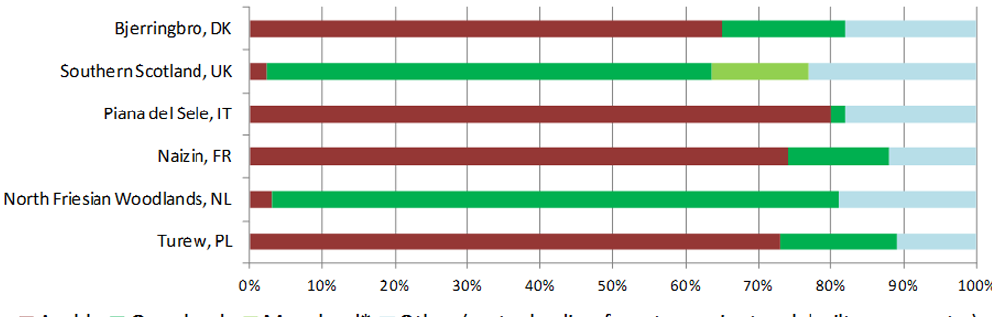
Fig. 2. Overall land use distribution in the six study landscapes 2007–2009. * Moorland and rough grassland account for about one fifth of the grassland in the Southern Scotland study area and are only extensively